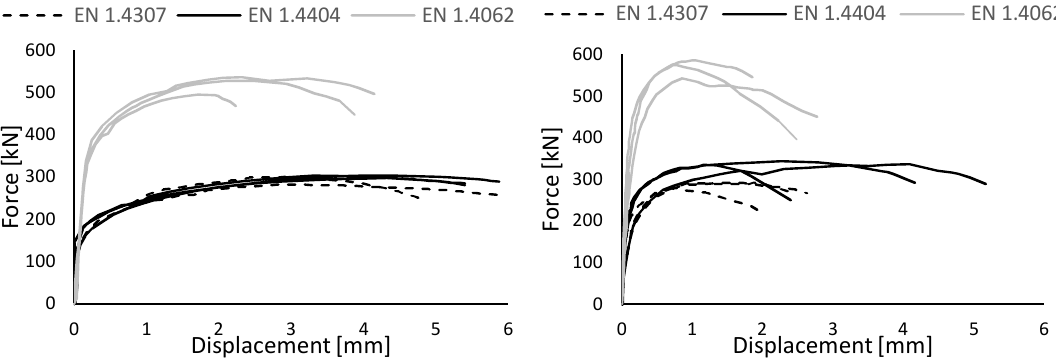
Figure 1. Load-displacement curves of longitudinal welds ( left ) and transverse welds ( right